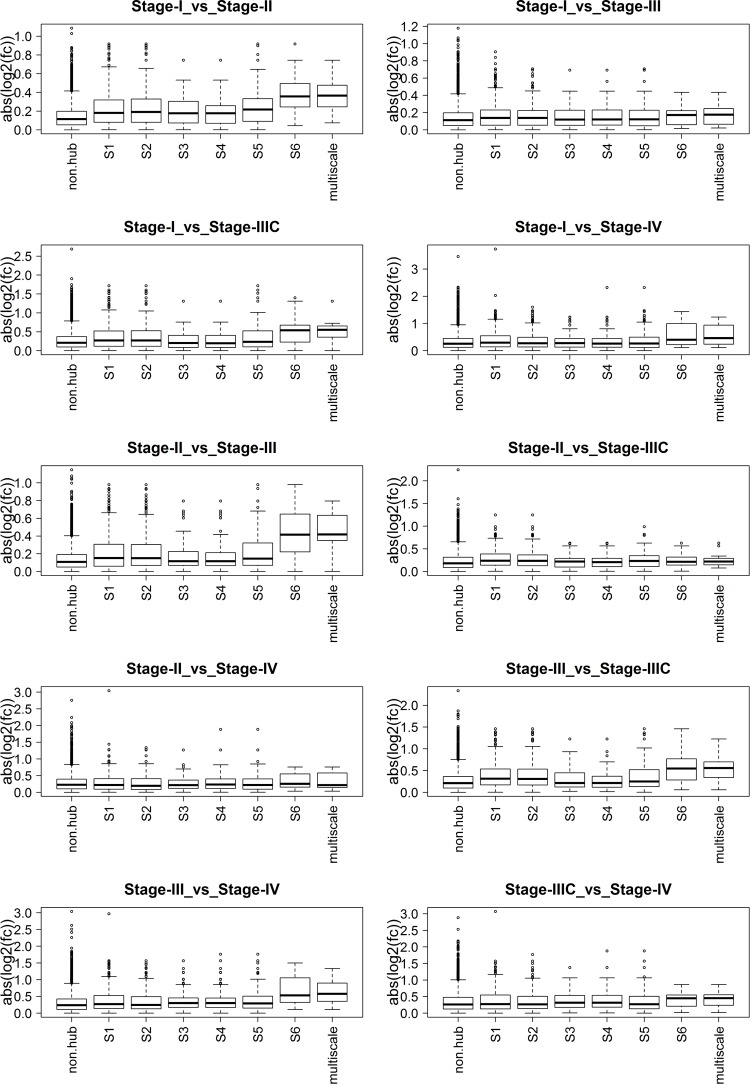
Comparison of expression fold changes (FC) of the hub genes and non-hub genes between different cancer stages in BRCA, against lists of genes identified by mutiscale hub analysis, where fc denotes expression fold change.The numeric labels on x-axis represent the ranges of α values defining the resolution levels of the hubs, “multiscale” represents intersection of hub genes across different scales, and “non.hub” represents the rest of genes.